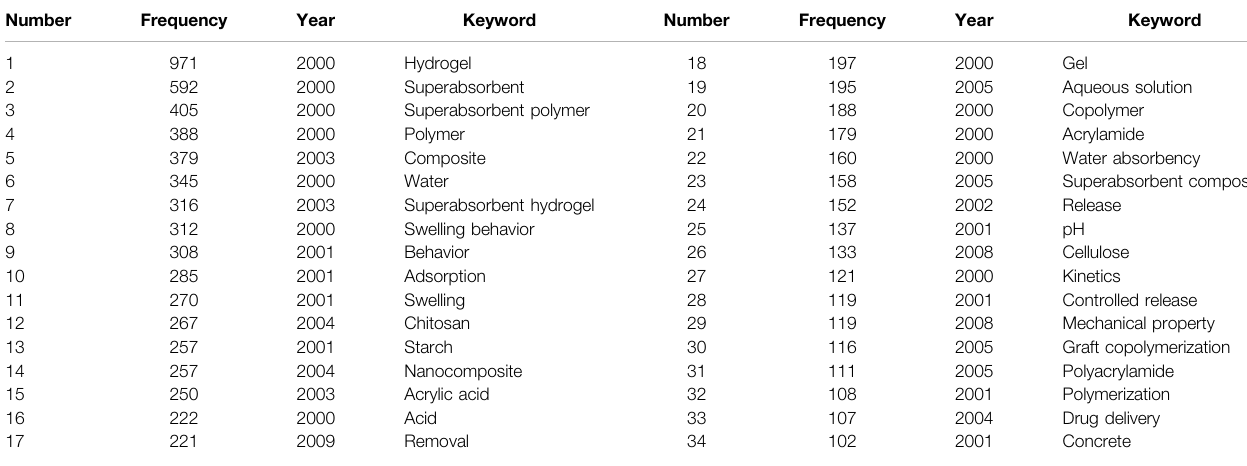
TABLE 1 | Research keywords in order of frequency in 2000 – 2019 (frequency > 100).